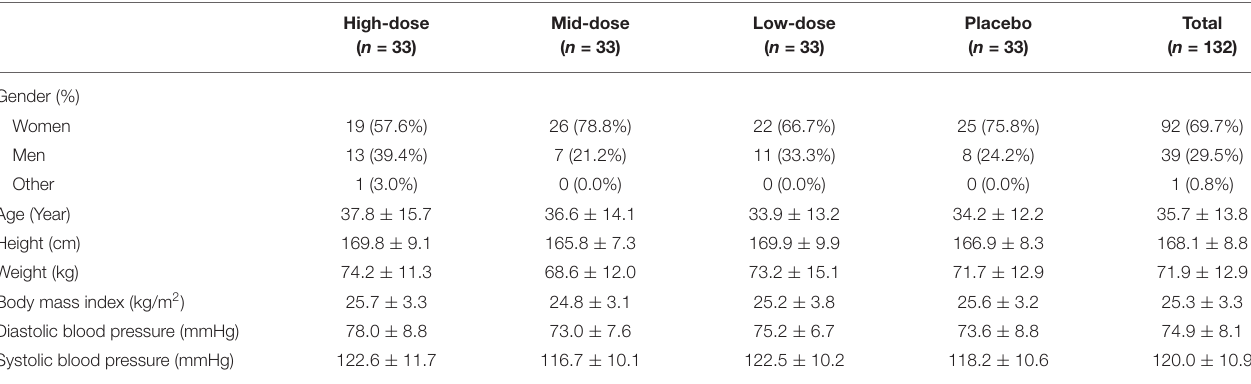
TABLE 2 | Characteristics of enrolled participants at